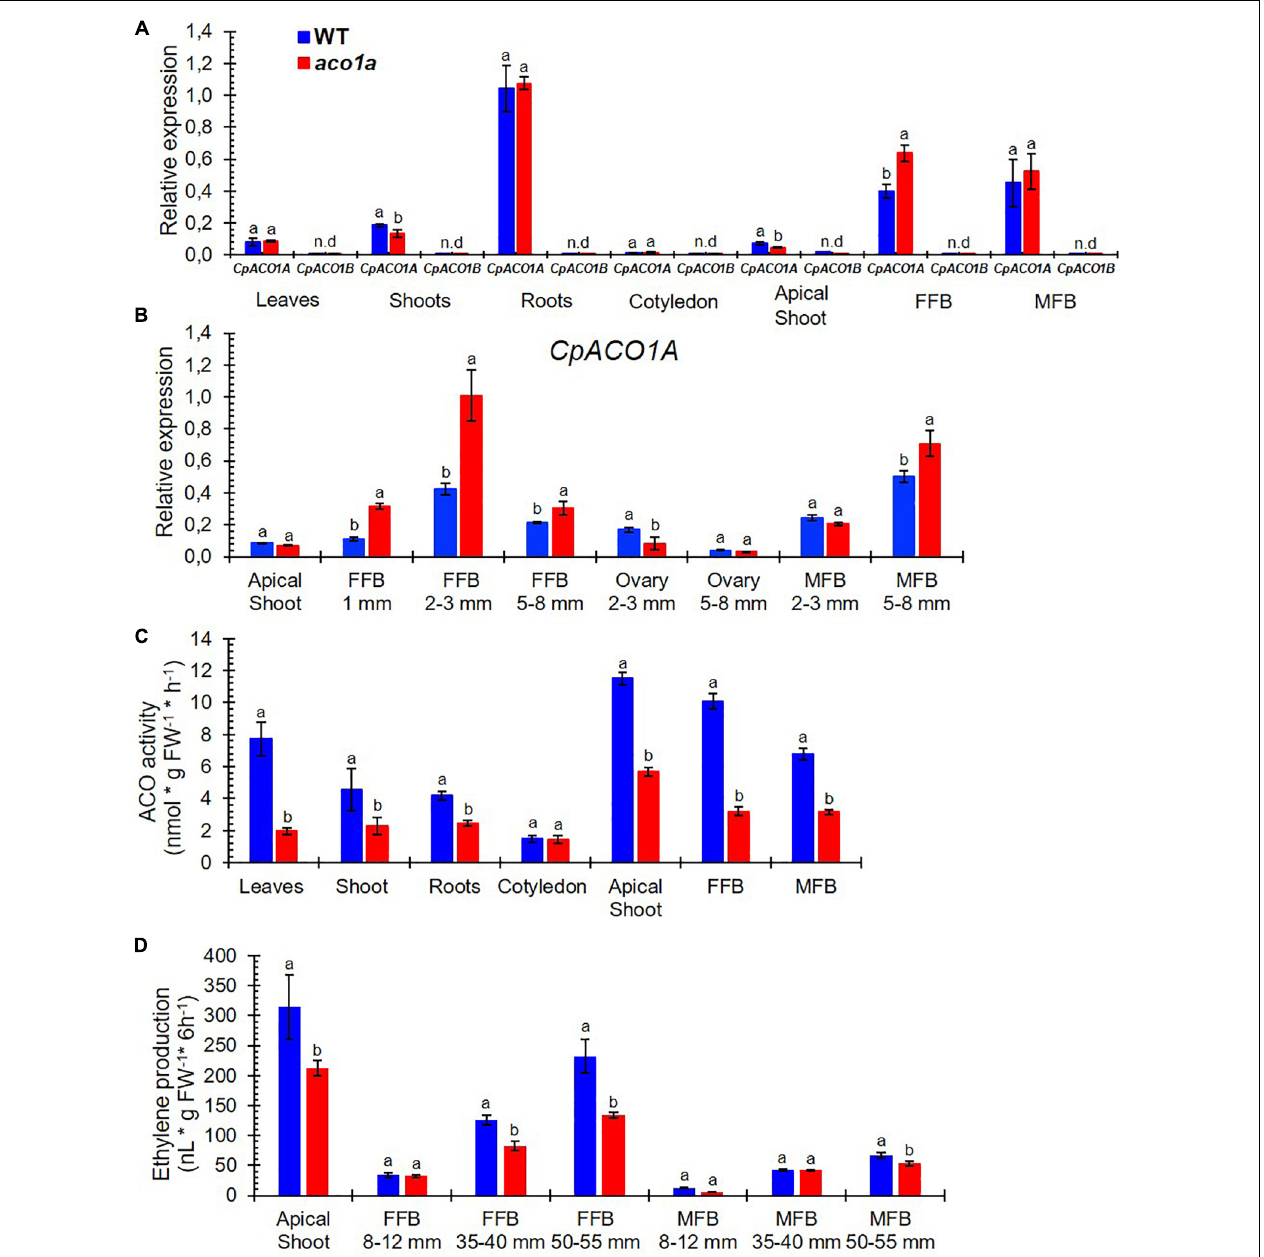
FIGURE 5 | Comparison of CpACO1A gene expression, ACO activity, and ethylene production in WT and aco1a plants. (A) Relative gene expression of CpACO1A and CpACO1B in different WT and aco1a plant organs. (B) Relative expression of CpACO1A in the apical shoots and in female and male floral buds at different stages of development. (C) ACO1 activity in different WT and aco1a plant organs. (D) Ethylene production in the apical shoot and in female and male floral buds of WT and aco1a plants. FFB, female floral bud excluding the ovary; MFB, male floral bud. The assessments were performed in three independent replicates for each tissue. Error bars represent SE. Different letters indicate significant differences between WT and mutant organs at the same stage of development ( p ≤